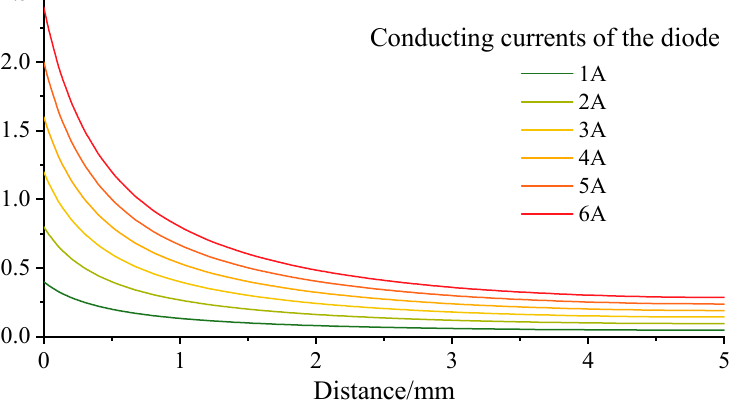
Figure 5. The results of the magnetic fi eld simulation for the diode pin line when the diode is con- ducting at ( a ) 1A, ( b ) 2A, ( c ) 3A, ( d ) 4A, ( e ) 5A, and ( f ) 6A. The curve corresponding to the values of di ff erent distances in space to the surface position of the diode pin line and the simulation result of the magnetic induction intensity B is shown in Figure 6.